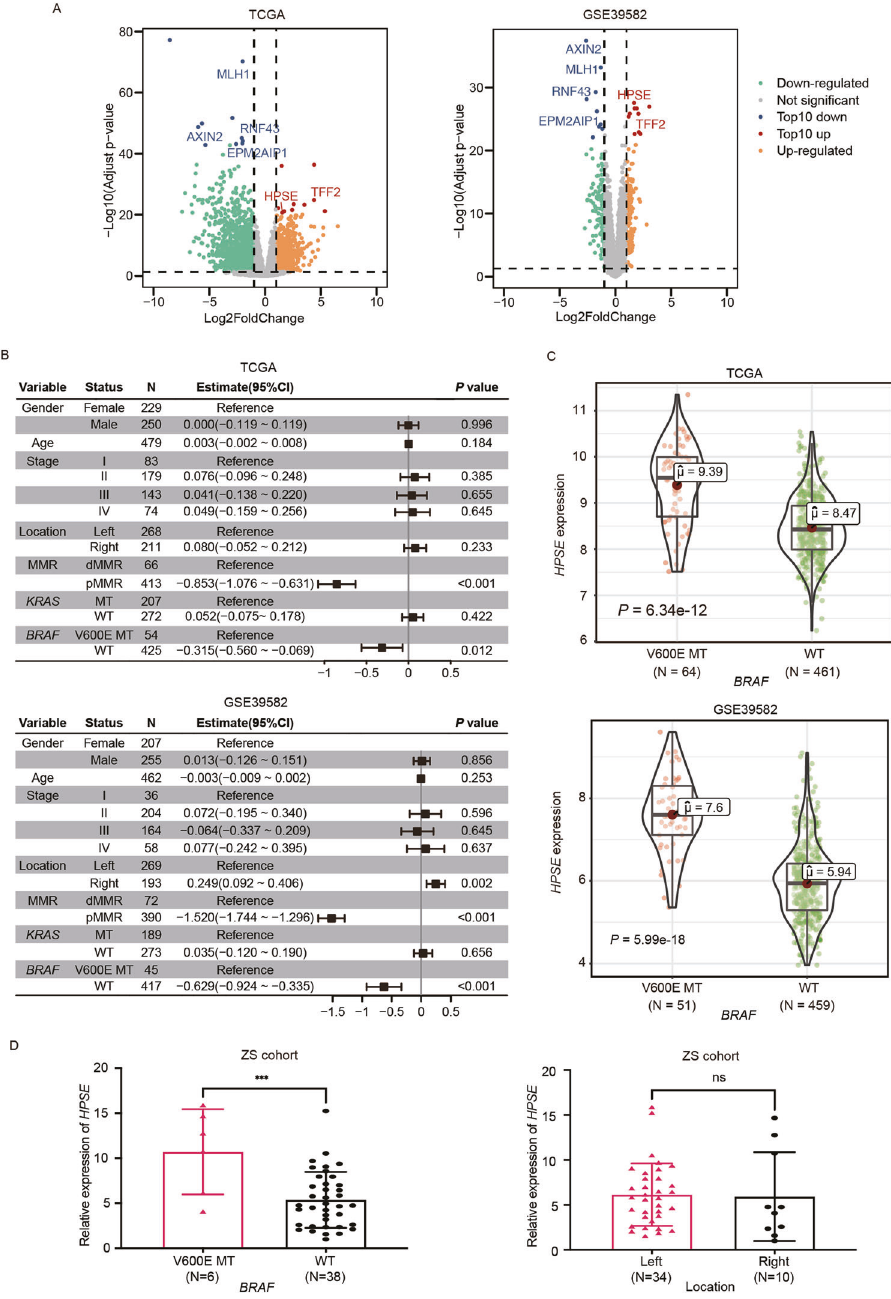
Fig. 1 HPSE expression level is signi fi cantly higher in BRAF V600E-mutant compared to BRAF wild-type patients. A Volcano maps of differentially expressed genes between BRAF V600E-mutant and wild-type colorectal cancer patients in the TCGA dataset (left) and GSE39582 dataset (right). Dots represent genes. Signi fi cantly upregulated and downregulated genes, based on a cutoff fold change of 2 and an adjusted P -value at 0.05, are colored in orange and green, respectively. The top 10 upregulated and downregulated genes are colored in red and blue, respectively. Common six genes were labeled with gene symbols. The ggpubr and ggthemes R packages were used to generate the map. B Multiple linear regression analysis of HPSE expression levels in public datasets. Samples with missing values were removed. F test P < 0.001 in TCGA and GSE39582 datasets. Estimate (blocks in the center) and 95% con fi dence intervals (Whiskers of error bars) are shown. CI con fi dence intervals. C Expression levels of HPSE in BRAF V600E-mutant and BRAF wild-type CRC patients based on public data. Dots in violin plots represent samples. Centerlines indicate median, red dots indicate the mean, box plots indicate the quartiles, and bars indicate 95% con fi dence intervals. Violin plots were generated using ggplot2 package and ggstatsplot package. A two-sided Welch ’ s t -test was used to determine P values. D Higher HPSE expression level in BRAF V600E-mutant CRC veri fi ed using frozen tissue of CRC samples from Zhongshan hospital. Locations of the primary tumor were unbalanced between BRAF V600E-mutant and wild-type samples (Table S2); however, no difference was reported in HPSE expression level between different primary tumor sites. Data are presented as mean ± standard deviation. The student ’ s t -test was used to calculate P values. *** P < 0.001, ns P >